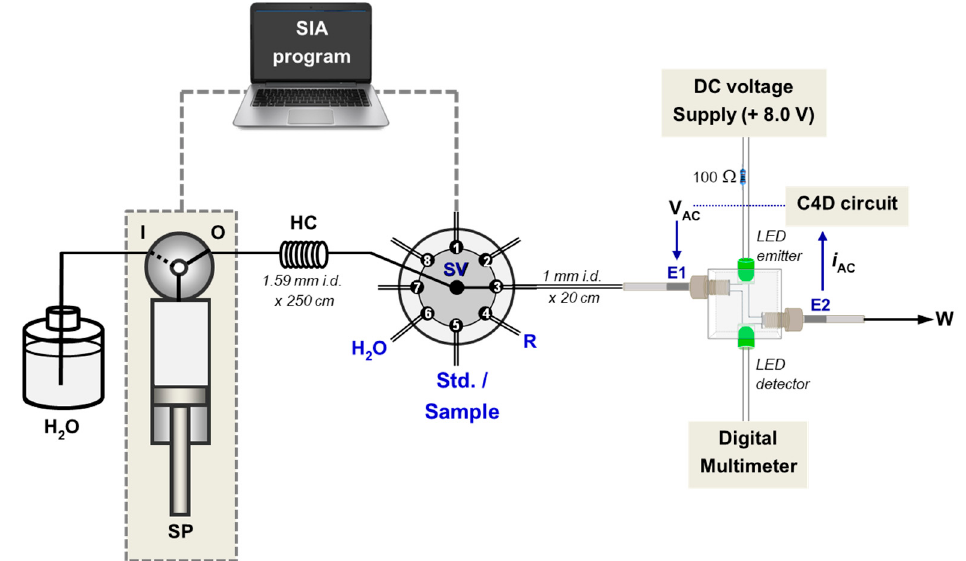
Figure 2. Schematic diagram of the SIA system coupled with the “2-in-1” flow cell for dual C4D-PEDD detection. Note: For the analysis of oral rehydration salt (ORS) samples, port 4 (labelled R) is not used. Port 4 is used as the inlet for the alkaline picrate reagent (R) in the sequential measurements of creatinine and conductivity of urine samples. SV—switching valve, SP—syringe pump, HC—holding coil, W—waste.